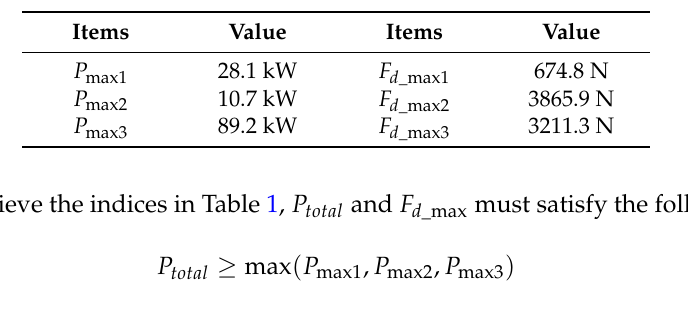
Table 3. Calculation results of the maximum powers and driving